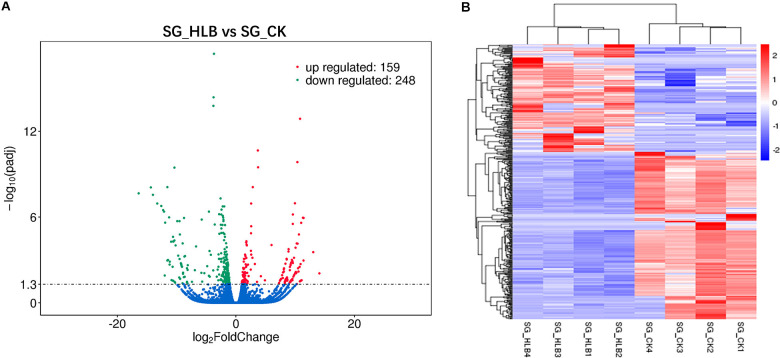
Volcano plot (A) and hierarchical cluster analysis (B) of differential expressed genes (DEGs). (A) The ordinate shows the significance level of difference in DEGs, and the abscissa represents the fold change of gene expression in different samples (log2 Fold change), respectively. Red, green, and blue points indicate upregulated, downregulated, and no significant difference genes, respectively. (B) Rows represent different DEGs, and columns represent different samples between CLas-infected and uninfected Diaphorina citri. Red color and purple color suggest high and low gene expression level, respectively.